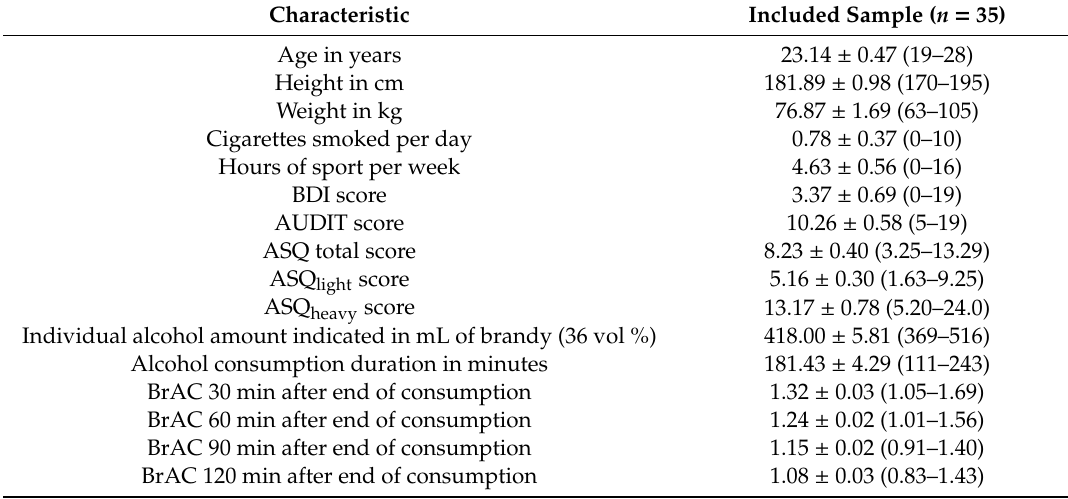
Table 1. Sociodemographic, questionnaire, and alcohol-related data of the included sample. All values are reported as means ± standard error of the mean and (range). Please note that all relevant items were averaged for the ASQ light score (alcohol-related experiences associated with lower doses). For the ASQ heavy score (alcohol-related experiences associated with heavier doses), all relevant items except for “passing out” were averaged, as only a single participant had indicated to have ever passed out due to alcohol drinking.